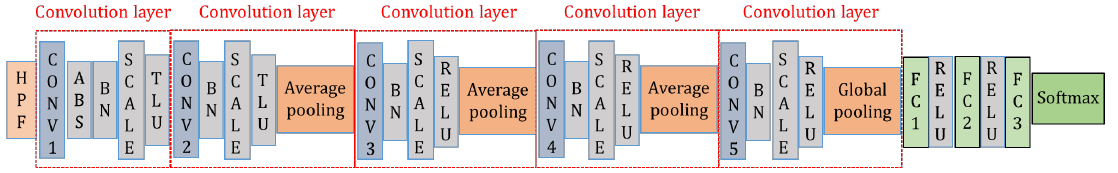
Figure 7. Structure of Yedroudj-Net